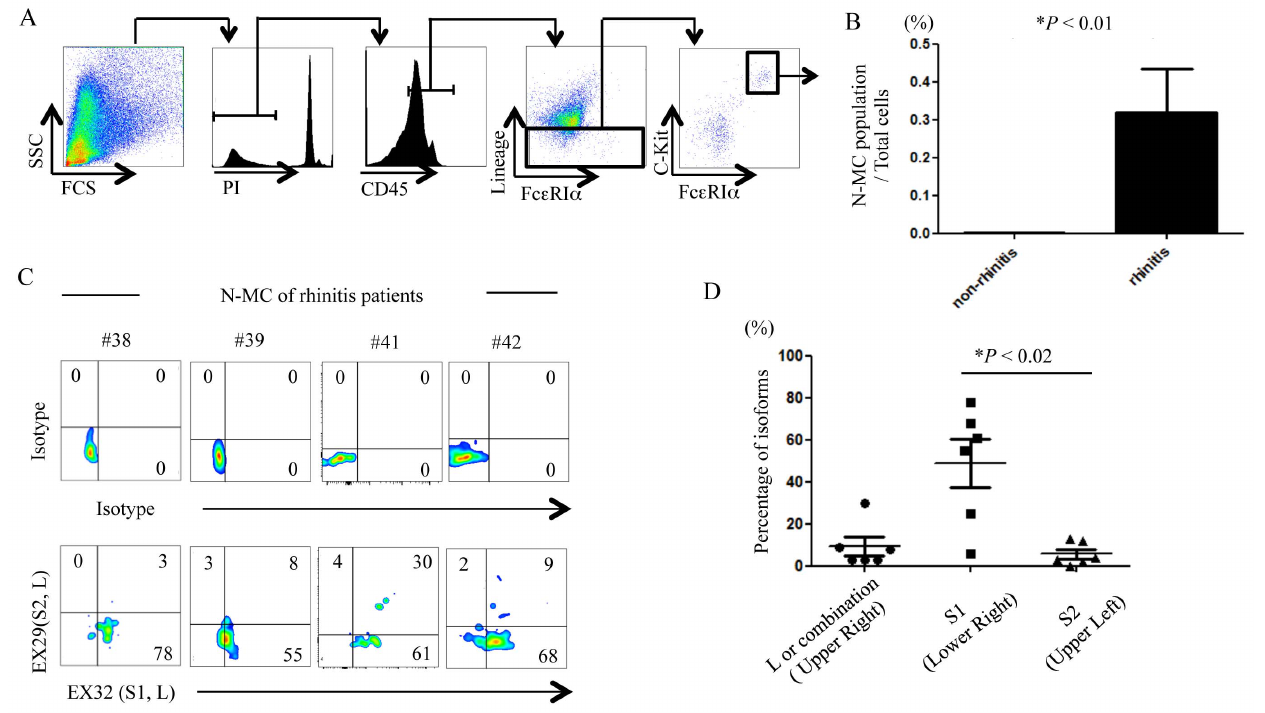
Figure 5. Expression of Allergin-1 isoforms on human N-MC. A, B. NSS cells obtained from 9 patients with allergic rhinitis or 5 healthy donors (non-rhinitis) were stained with PI, anti-CD45, lineage cocktail, anti-Fc e RI a , and anti-c-Kit mAbs and analyzed by flow cytometry (A). The frequencies of N-MC population were compared between two groups (B). C, D. NSS cells obtained from 6 patients with allergic rhinitis were stained with mAbs, as described in A, together with EX32 and EX29 mAbs, and analyzed by flow cytometry. Representative flow cytometry profiles of four patients are shown (C). ‘‘Combinations’’ indicates MC in the upper right quadrant that express either L + S1, L + S2, L + S1 + S2, or S1 + S2 (D).